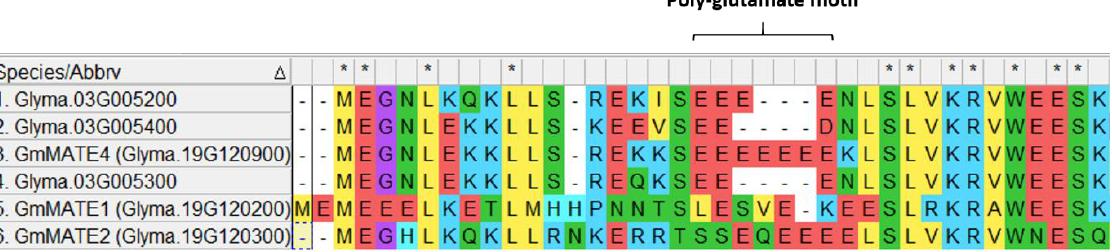
Figure 2. Alignment of the N-terminal amino acid sequences of Glyma.03G005200, Glyma.03G005300, Glyma.03G005400, GmMATE4, GmMATE1, and GmMATE2. The alignment of the full protein